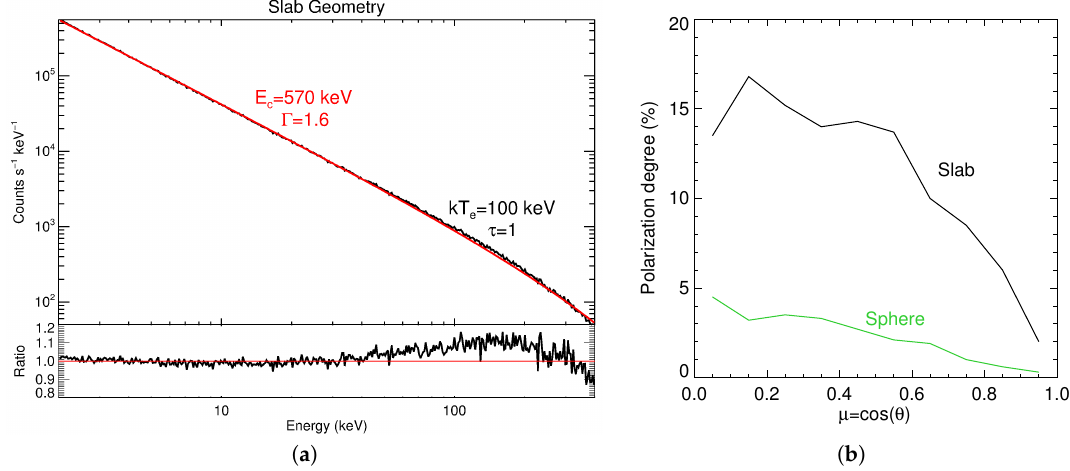
Figure 2. ( a ) The X-ray spectrum simulated for a slab corona with kT e = 100 keV, τ = 1.0 with Monte Carlo code for Comptonization in Astrophysics (MoCA) (in black), fitted with a power law model (in red) is shown. Residuals are reported in the bottom panel; ( b ) The polarization degree is plotted against the cosine of the inclination angle for two different geometries (see text for